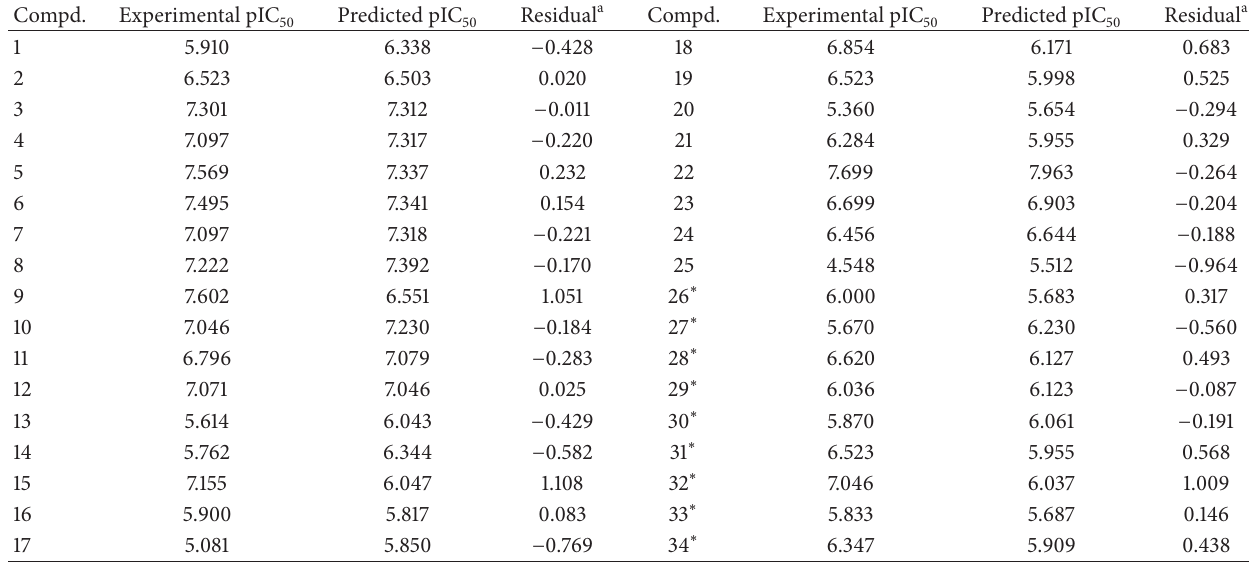
Table 3: The comparison of experimental and predicted activities of 34 compounds in training set and test set. Compd.